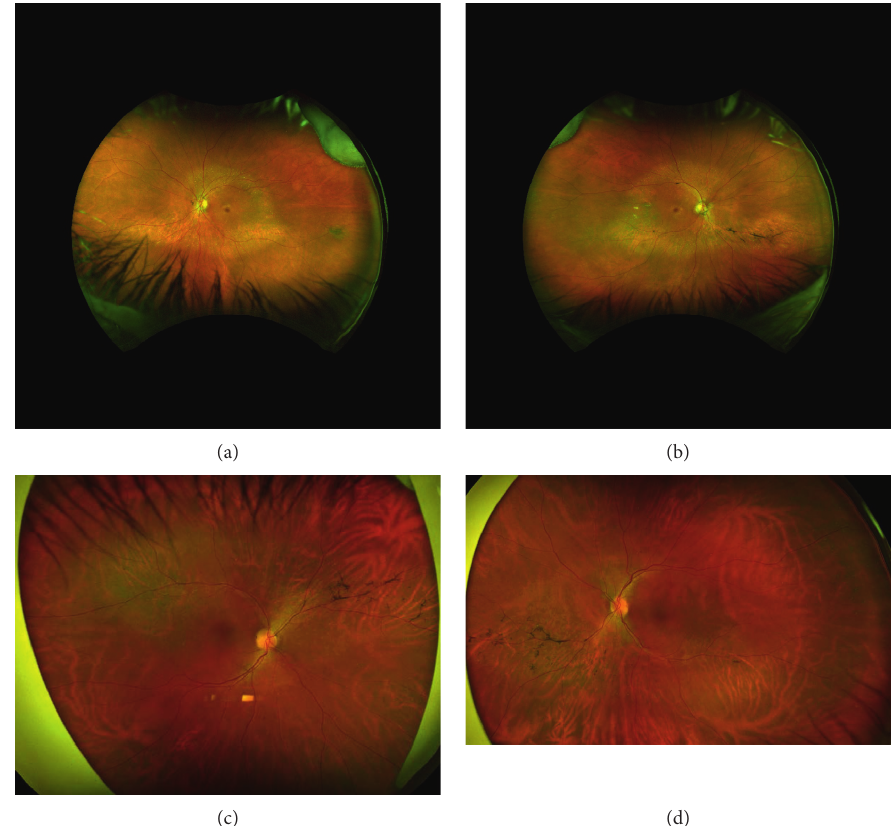
Figure 1: Color scanning laser ophthalmoscopy (Optos California): (a) and (b) images of the patient’s right eye and left eye, respectively, showing minimal bone spicule pigmentation largely in the right eye, with circumferential midperipheral atrophy in both eyes. (c) and (d) Images of the offspring’s right eye and left eye, respectively, showing similar inferonasal perivascular pigmentary clumping and bone spicule formation in both